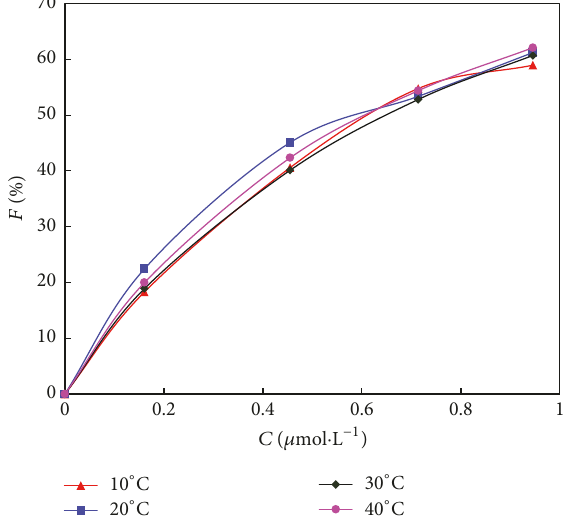
Figure 7: The comparison of O 2∙− scavenging activity of FK-Gly at different pH values.